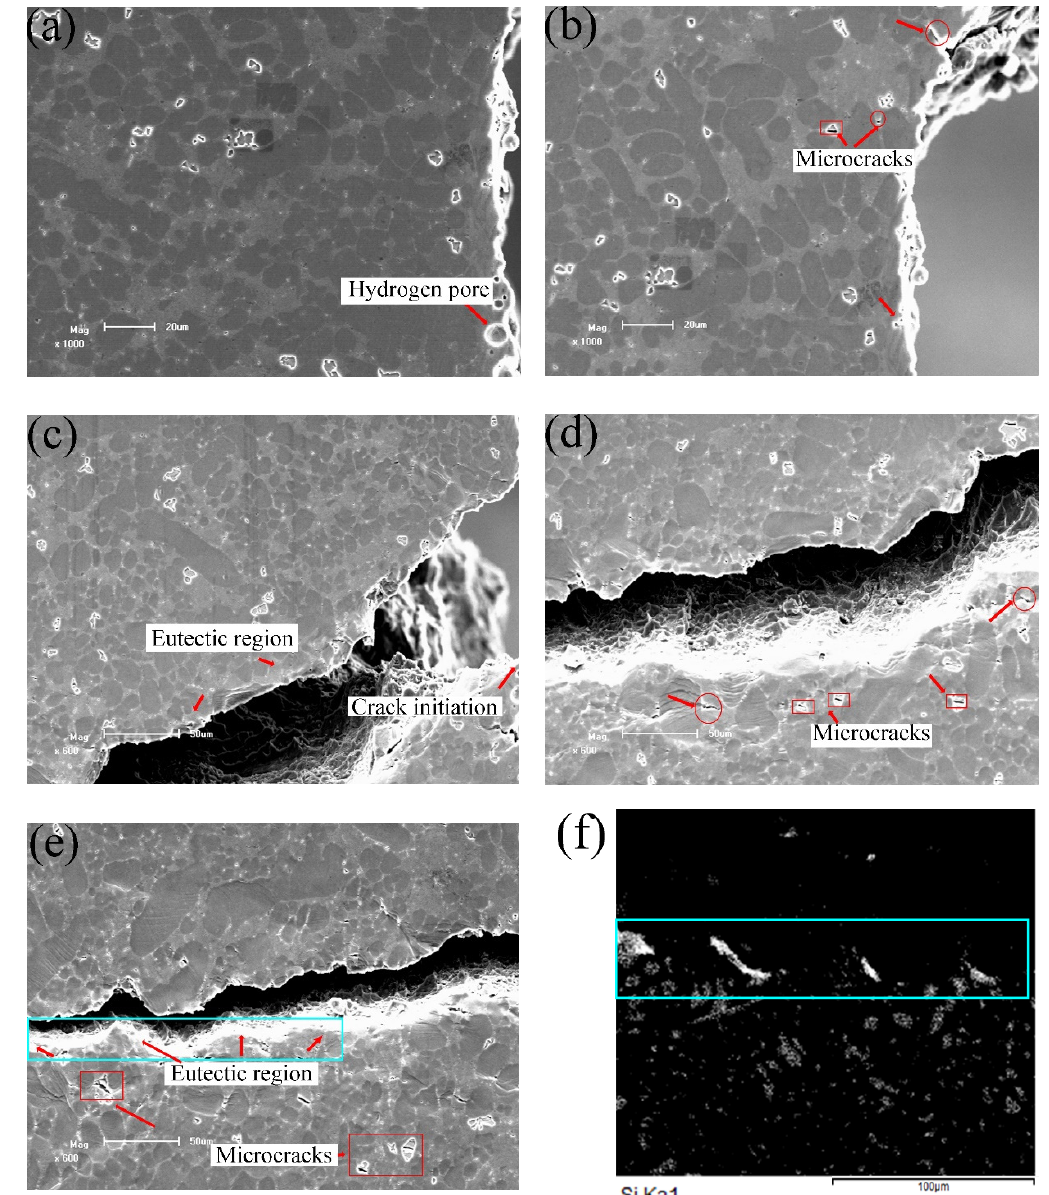
Figure 6. In-situ scanning electron microscopy (SEM) images of the as-cast alloys at stress / load level of: ( a ) 0 MPa / 0 N, ( b ) 256 MPa / 710 N, ( c ) 270 MPa / 760 N, ( d ) 270 MPa / 760 N, ( e ) 270 MPa / 760 N, and ( f ) the EDS mapping of Si element in the rectangle region in (e).